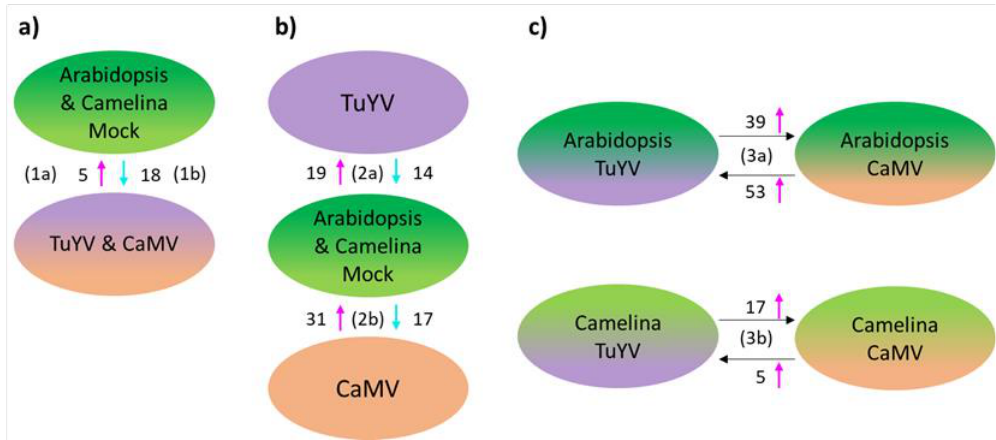
Figure 4. Summarizing figure presenting the number of differentially expressed aphid genes (log2FC > 0.5 or <0.5) discussed in each subsection of the discussion (1a, 1b, 2a, 2b, 3a, 3b). a) differentially expressed aphid genes in common for all conditions, b) virus-specific aphid DEGs common on both host- plants, and c) host plant-specific aphid DEGs for TuYV vs CaMV. Magenta arrows indicate the number of upregulated genes and the cyan arrows the number of downregulated